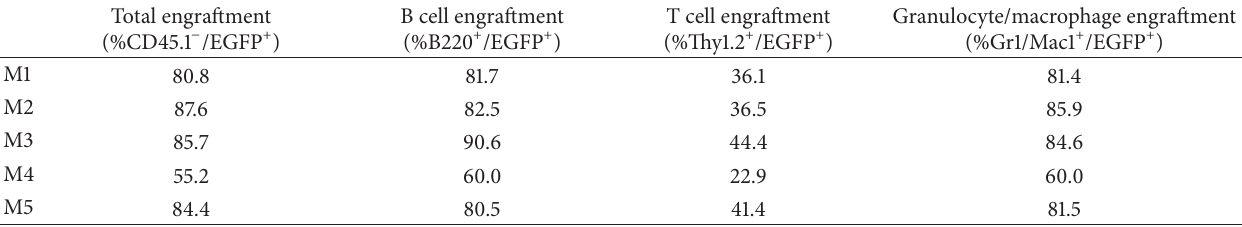
Table 1: Nonadherent fraction bone marrow transplantation results in multilineage hematopoietic engraftment. Total